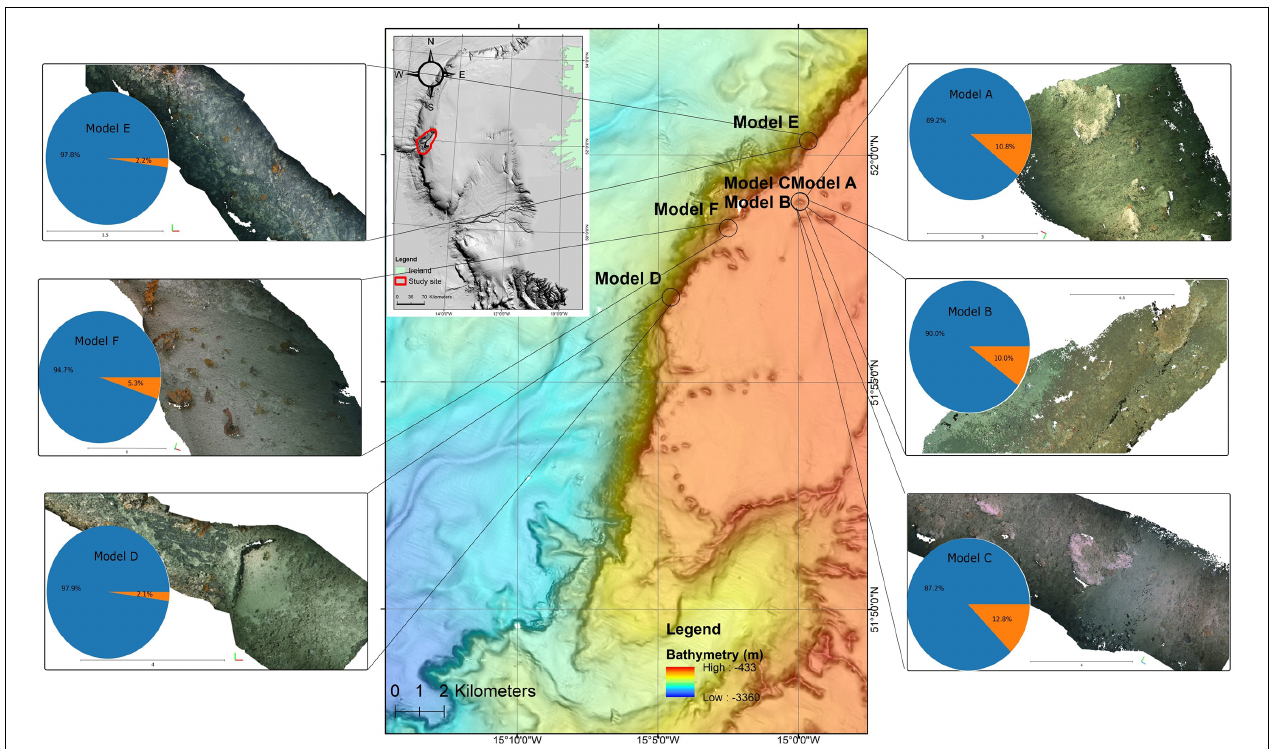
FIGURE 3 | Map showing the location of the Porcupine Bank Canyon on the Irish continental shelf and the location of each SfM reconstructed dense cloud produced in this study and its respective class distribution with manual annotation. Blue represents seabed and orange represents coral.